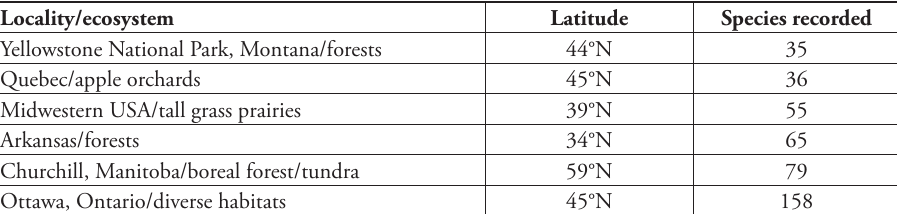
Table 2. Microgastrinae diversity in selected North American localities. Data from Lewis and Whitfield (1999), Whitfield and Lewis (2001), Shaw (2002), Fernandez-Triana et al. (2009, 2011), and the present paper. Locality/ecosystem Latitude Species recorded Yellowstone National Park, Montana/forests 44°N